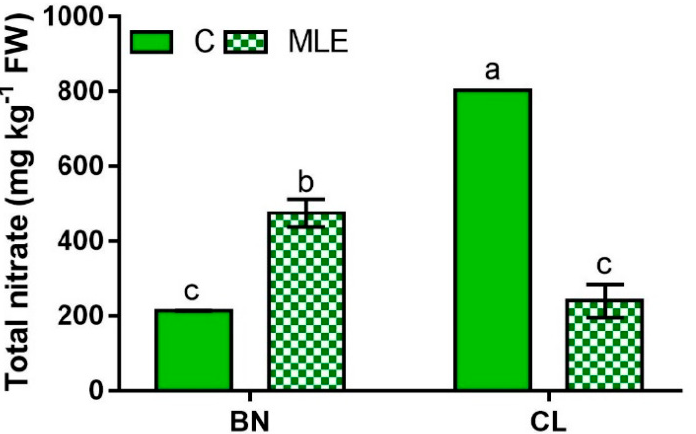
Figure 5. Effect of interactions of total nitrate content from leaves of BN and CL treated with distilled water (C) and moringa leaf extract (MLE). Values are the means ± SE ( n = 3). Different letters indicate the differences among treatments.